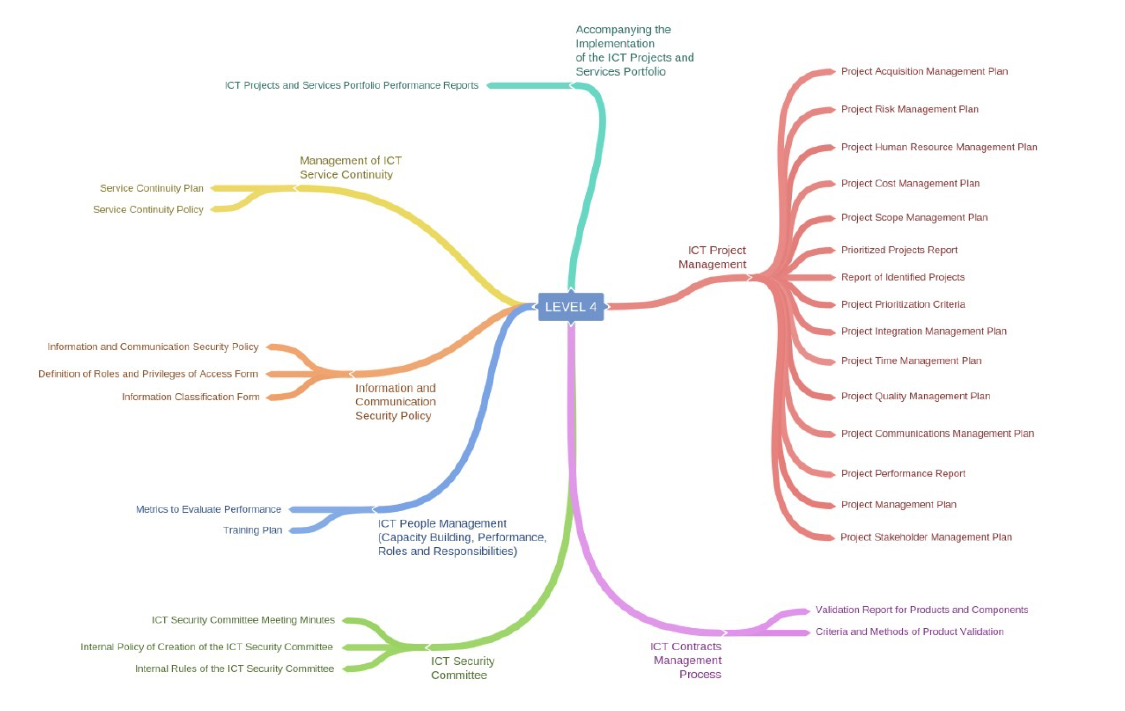
Figure 5. Processes of Kit 3, Level 4.